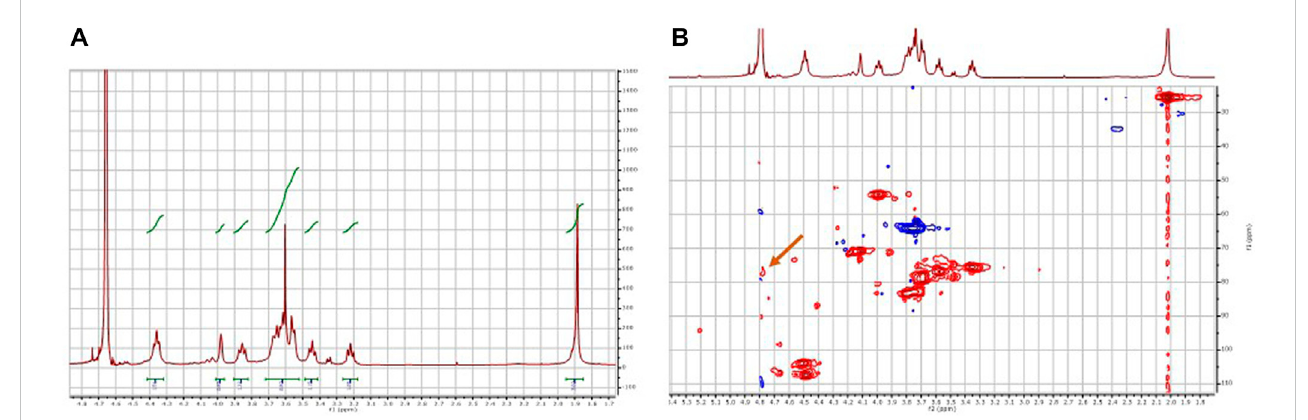
FIGURE 9 NMR analysis of the product of the biocatalytic sulfation cascade. (A) 1 H-NMR spectrum, (B) 2D HSQC spectrum. The arrow in panel (B) indicates the crossing signal δ 1 H = 4.77 δ 13 C = 77.3 ppm corresponding to the sulfated C4 of N -acetylglucosamine.